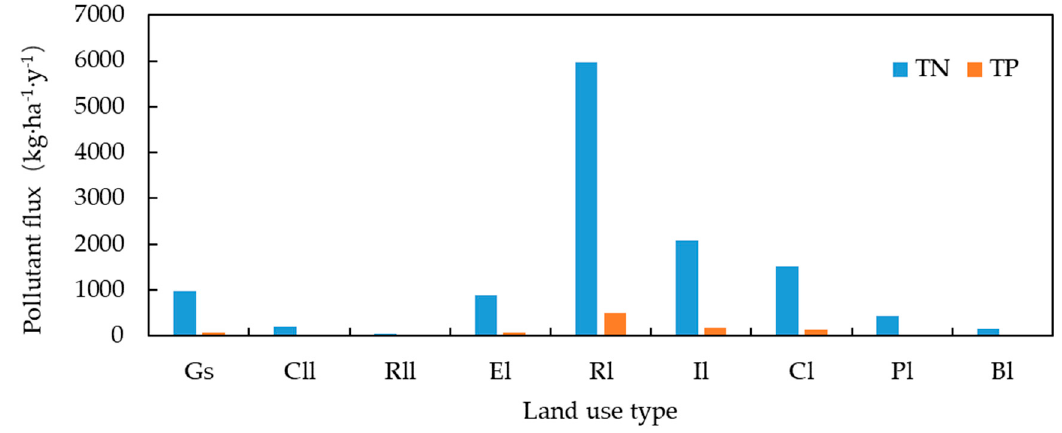
Figure 4. Pollutant flux of different land use types in 2018. The abbreviations on the x-axis are expanded as follows: Gs- Green spaces; Cll-Cultivated land; Rll-Religious land; El-Education land; Rl-Residential land; Il-Industrial land; Cl-Commercial land; Pl-Public services land; Bl-Bare land.